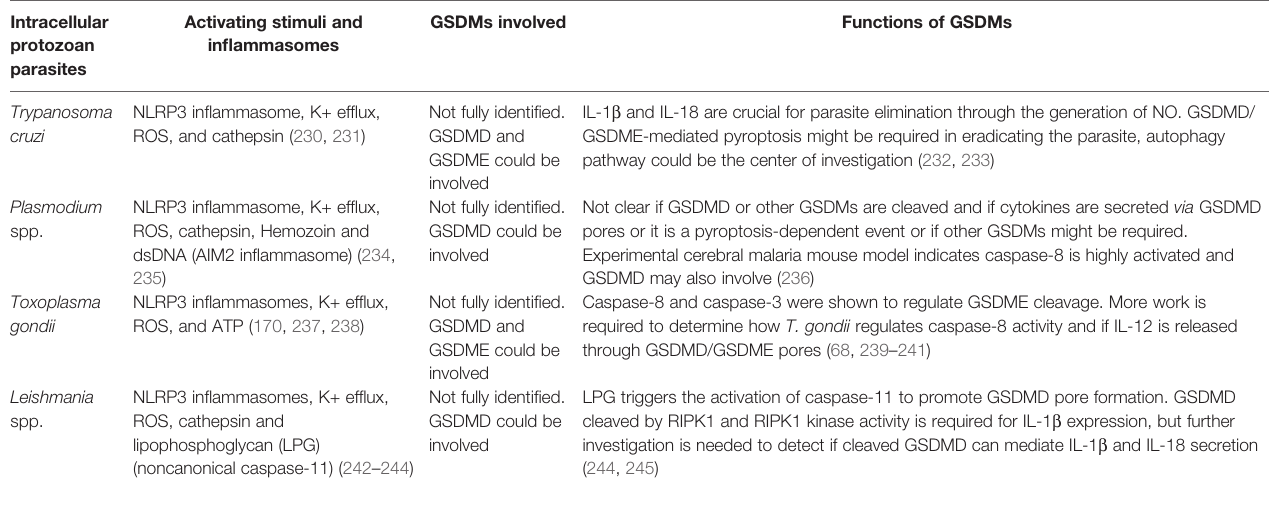
TABLE 3 | The signaling and functions of gasdermin proteins defend against intracellular protozoan parasite infection. Intracellular protozoan